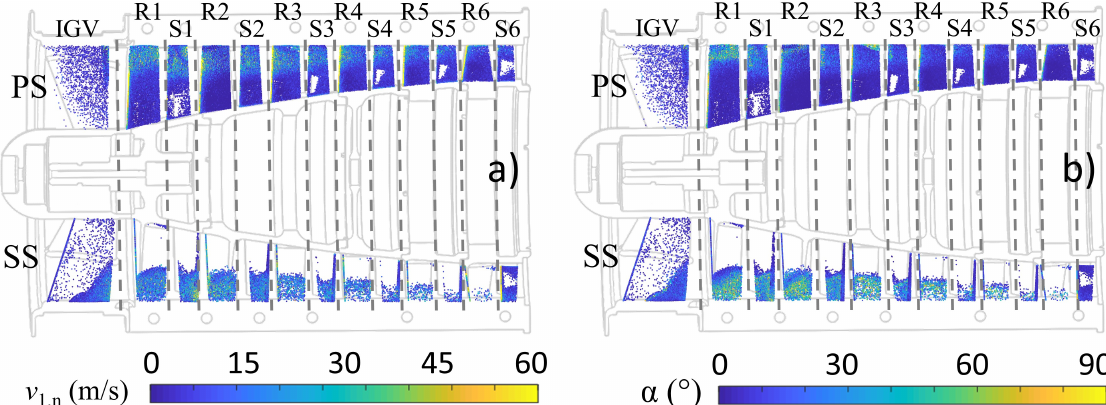
Figure 9. Particle impact behavior over the compressor stages: ( a ) normal impact velocity; and ( b ) impact